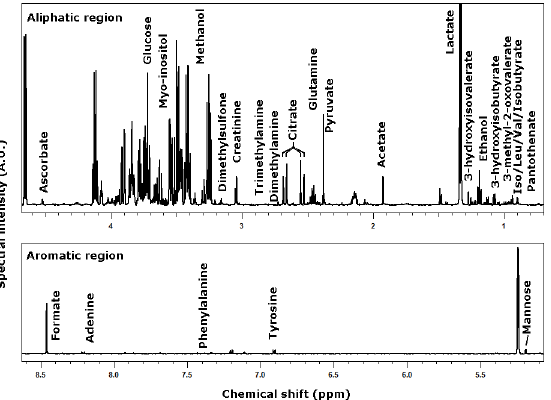
Fig 1. A 1D-NMR spectrum of CSF from a 30d pig, representative of all the registered